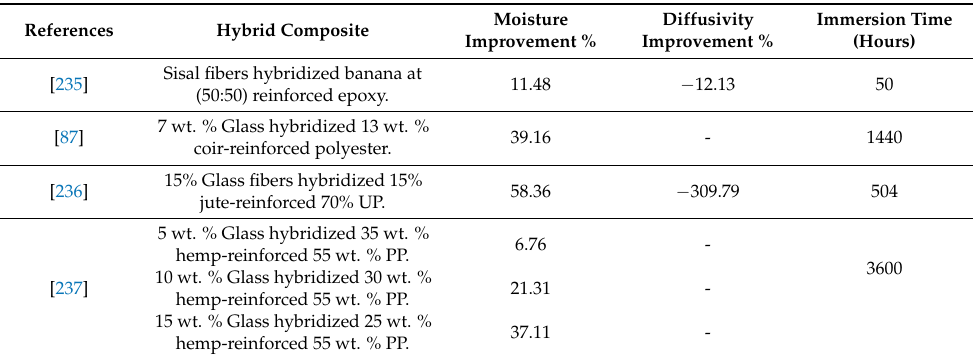
Table 3. The effect of hybridizing natural fibers on moisture absorption